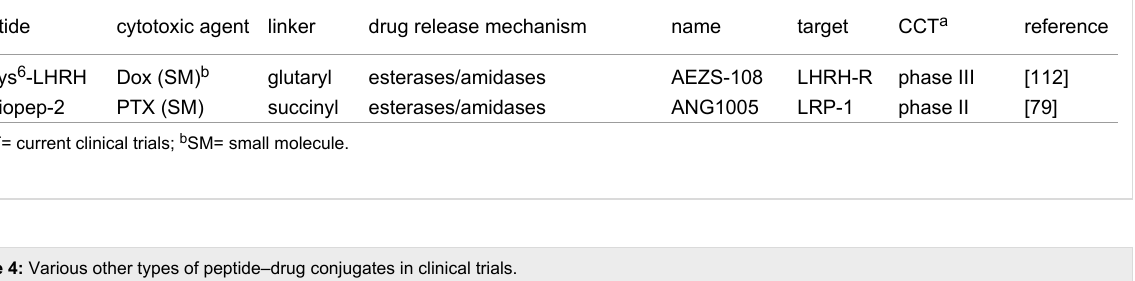
Table 4: Various other types of peptide–drug conjugates in clinical trials. peptide